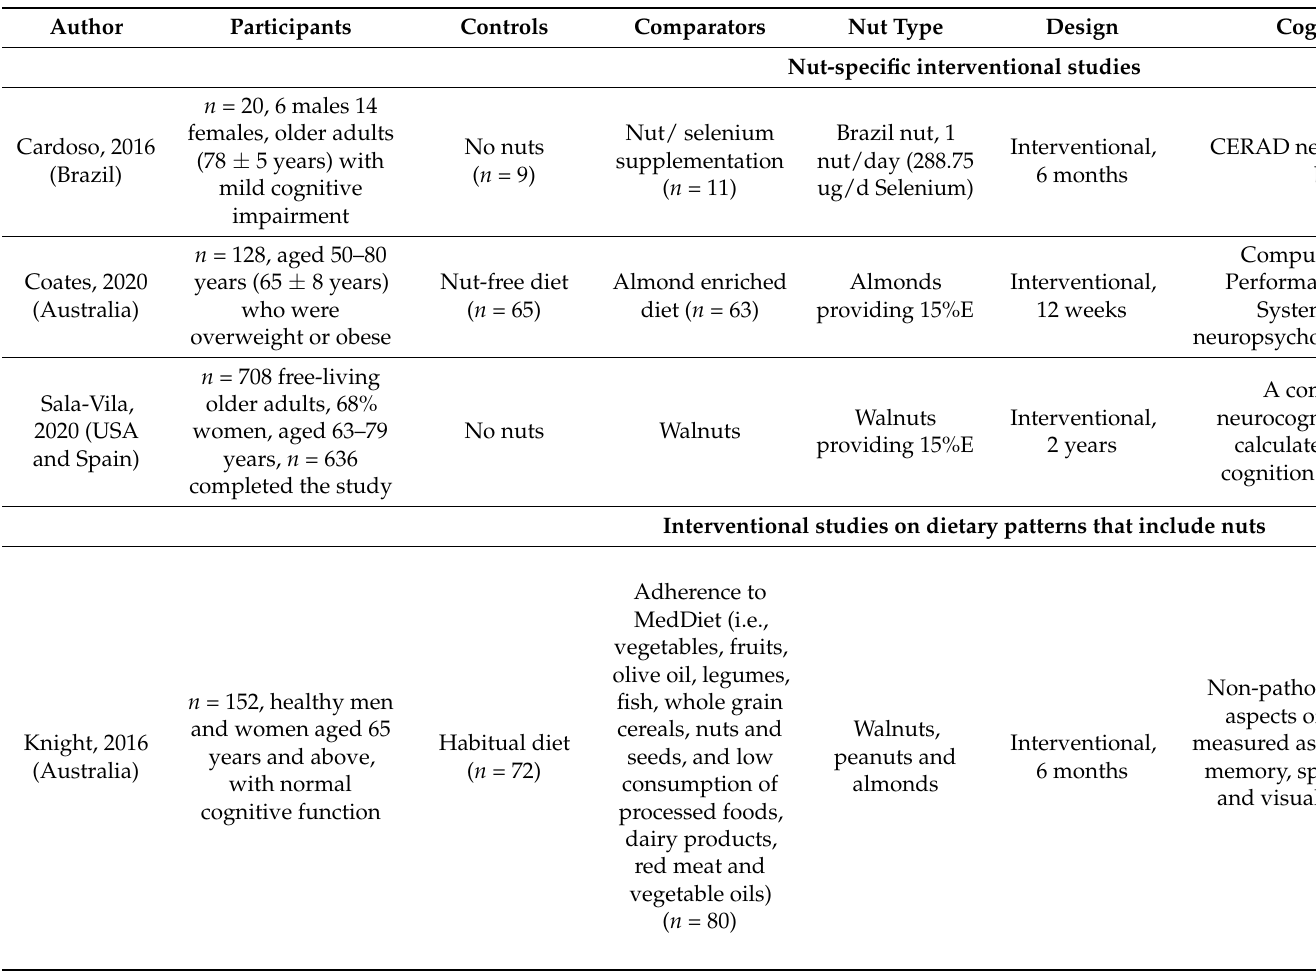
Table 4. Interventional studies examining the effects of nut consumption on